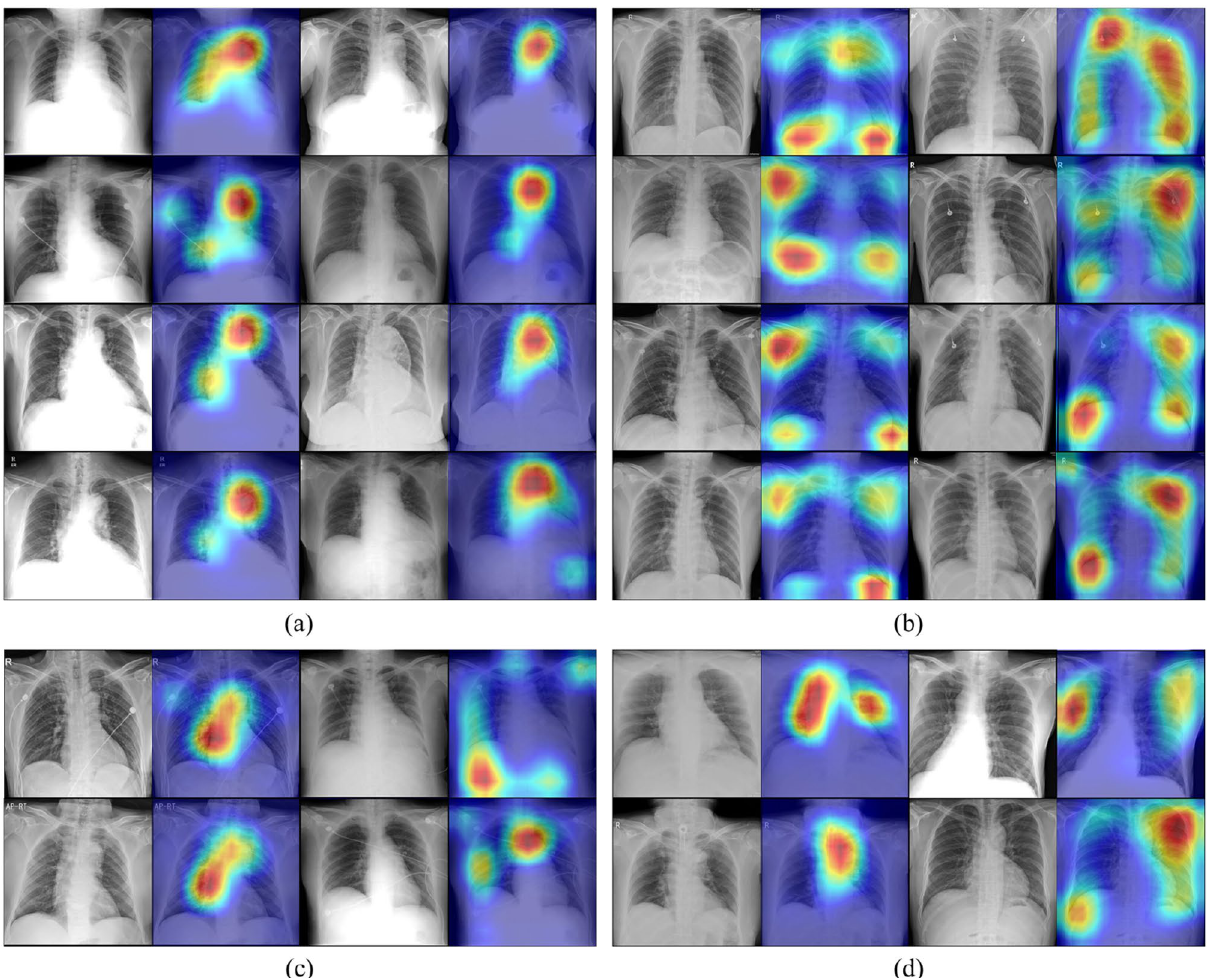
Figure 7. The regions of interest for aortic dissection diagnosis were visualised as heat maps based on Grad- CAM following the confusion matrix categories: ( a ) true positive, ( b ) true negative, ( c ) false positive, and ( d ) false